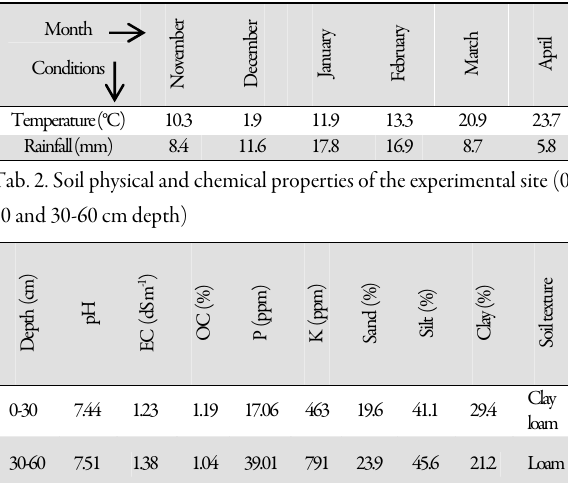
Tab. 1. Mean monthly temperature and rainfall during crop growth